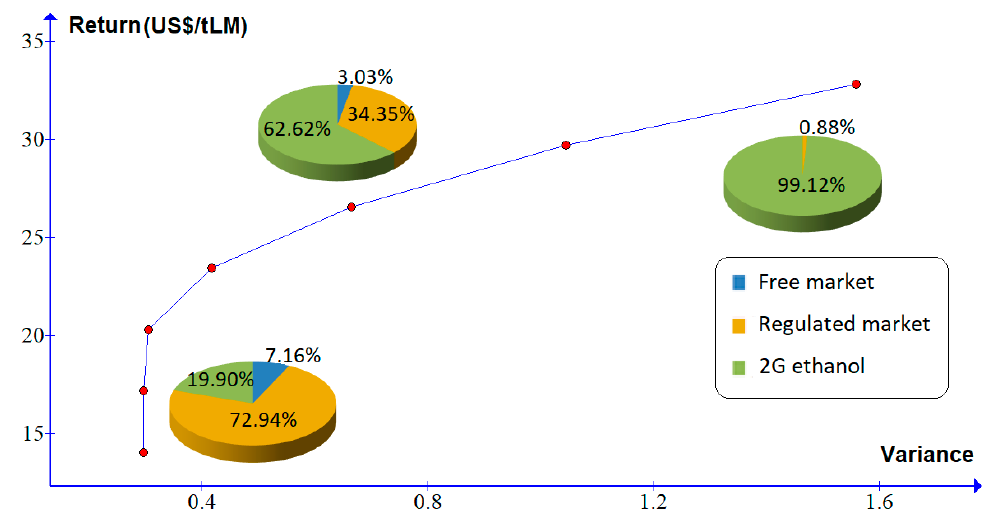
Figure 6. Efficient frontier for scenario 4.